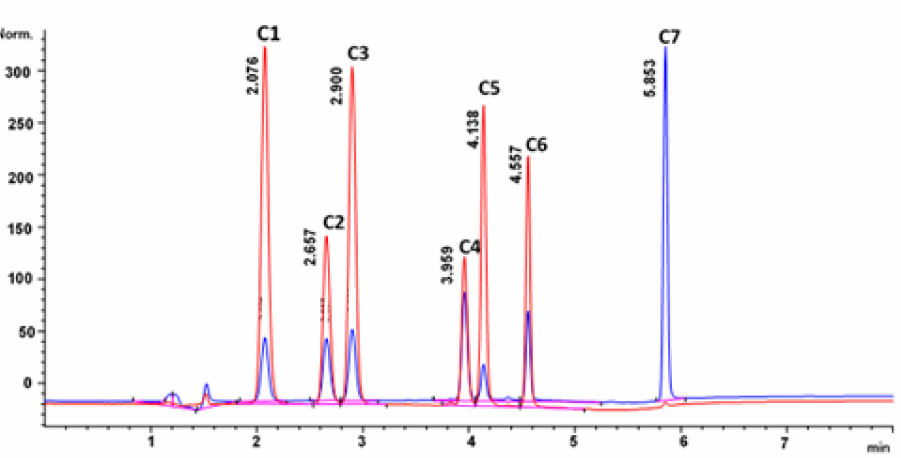
Figure 6. Typical chromatogram of separation of the C 1–7 under optimised conditions by gradient elution mode; at 0 min 25% B, 2 min 40% B, 3 min 65% B, 4 min 100% B with a run time of 6.5 min. Injection volume of 5 µ L, flow rate of 1.3 mL min − 1 and temperature of 25 ◦